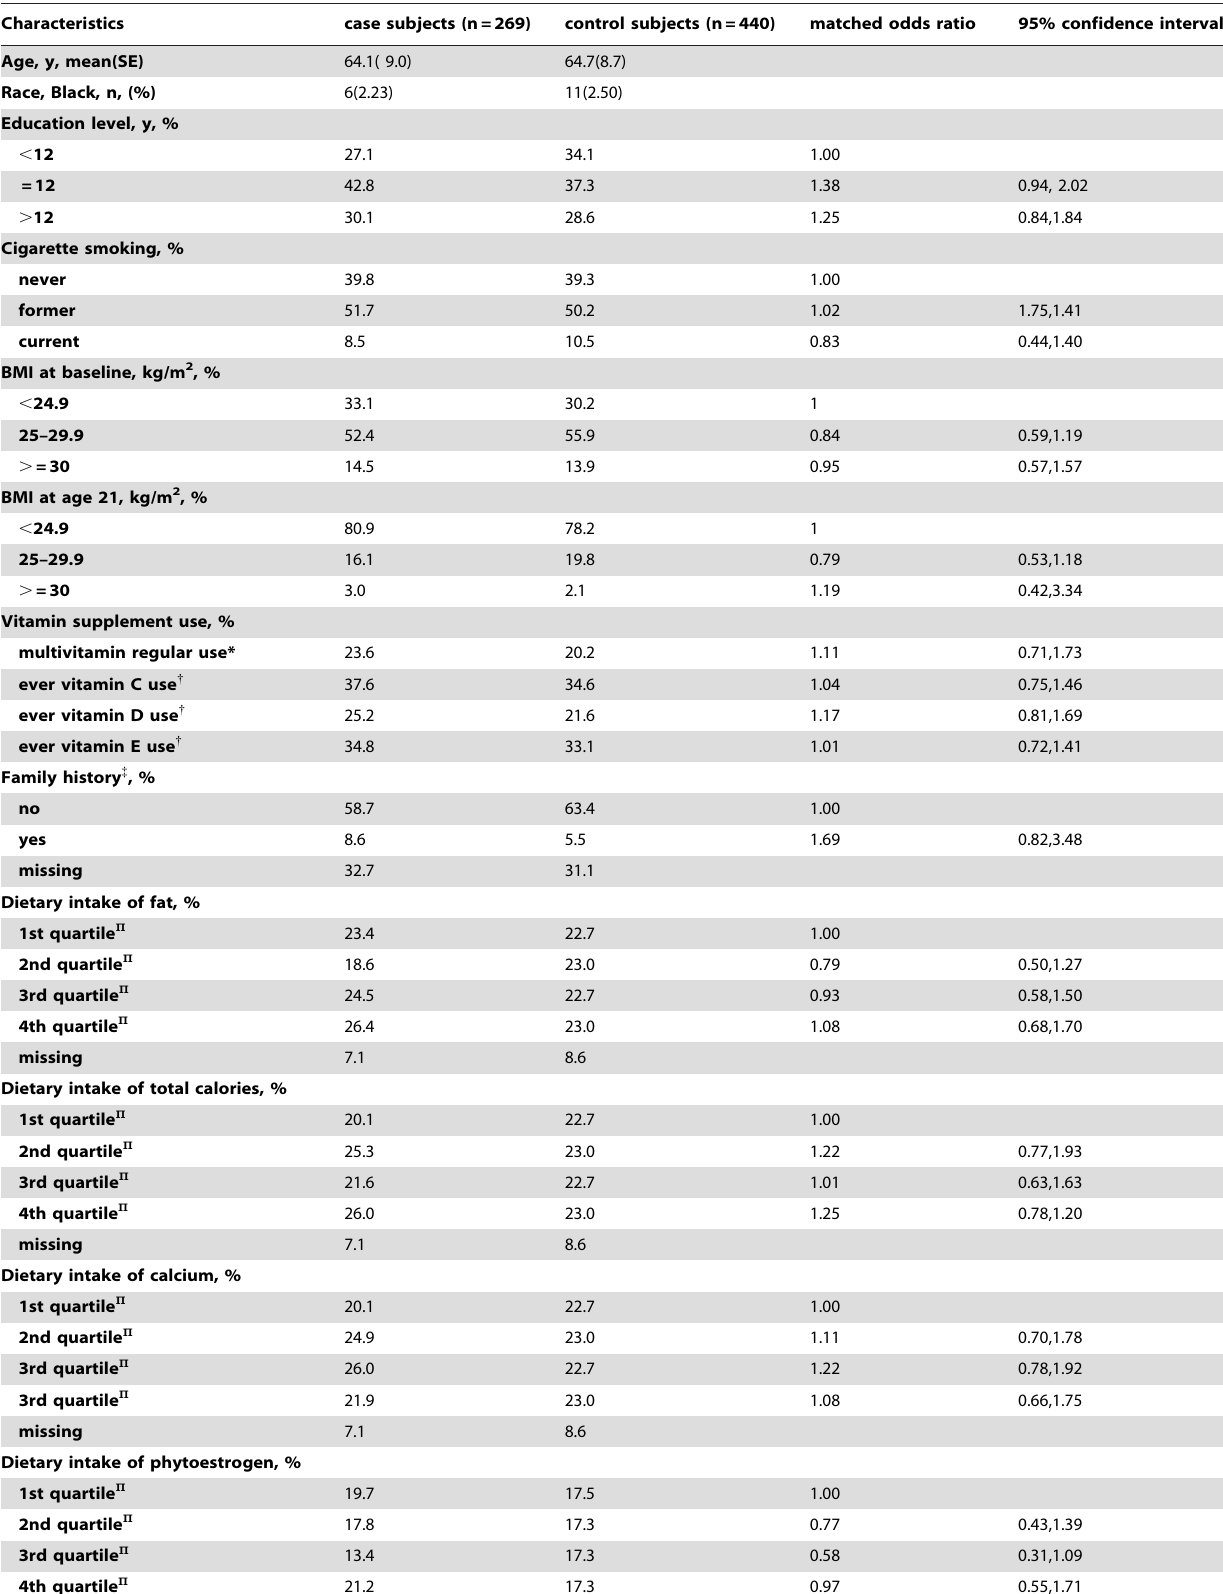
Table 1. Characteristics of prostatic cancer cases and matched controls in the CLUE 2 cohort,